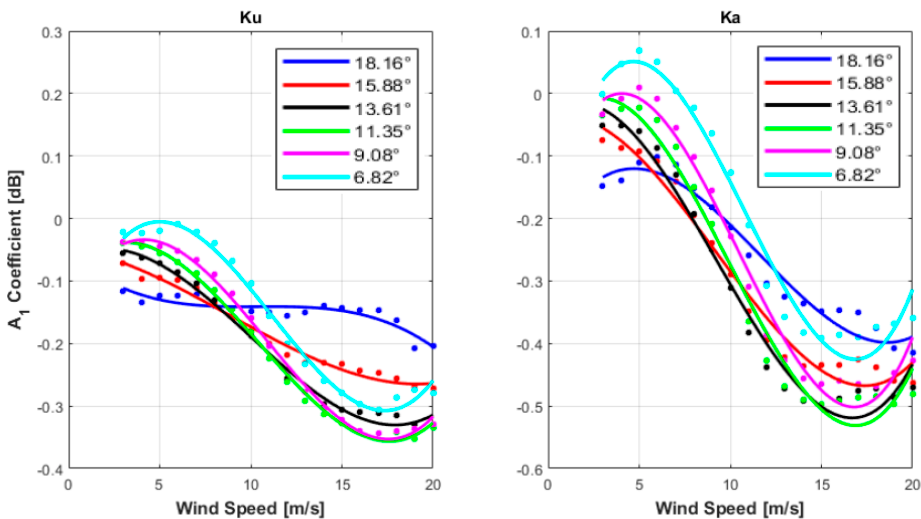
Figure 11. A 1 coefficient of KuPR( left ) and KaPR ( right ) σ 0 models (in dB) as a function of wind speed at different earth incidence angles. The symbols are Fourier coefficients while the solid lines represent their 3rd order regression fits.